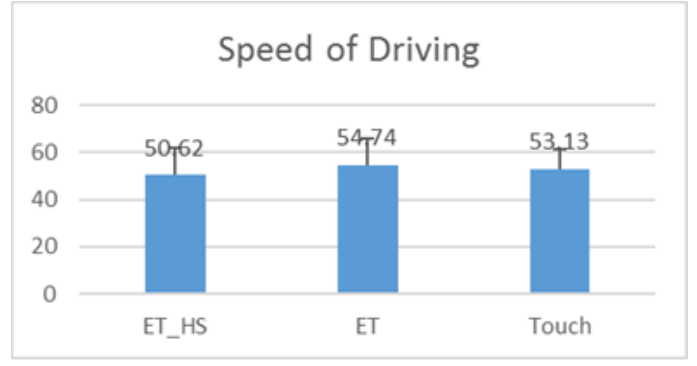
Figure 15. Comparing Driving Performance in terms of average speed of driving.